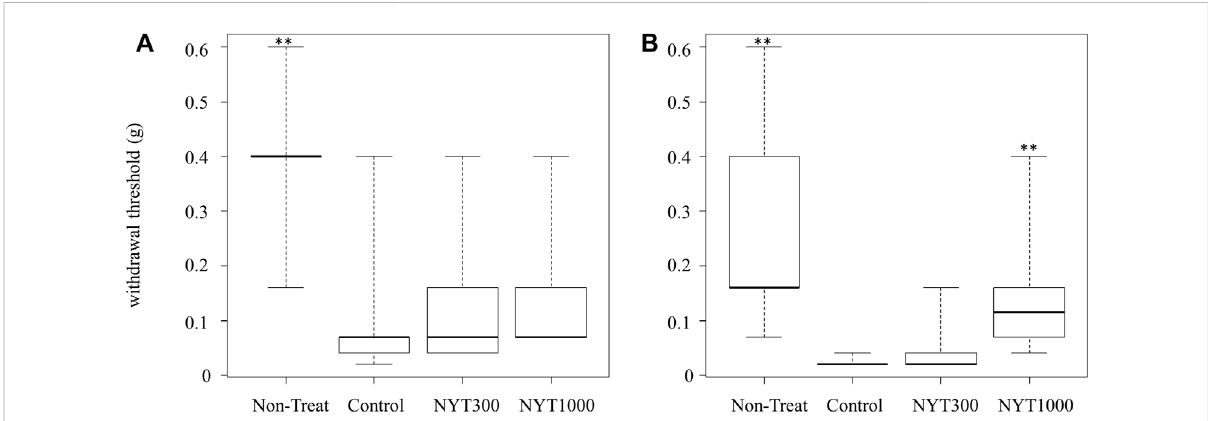
FIGURE 2 Effect of NYT on CIA-induced mechanical allodynia. (A) First week. (B) Fourth week after second antigen administration (Number of legs; each group n = 14). Values are expressed as median [25th percentile, 75th percentile]. pp p < 0.01 vs. control group by steel test.